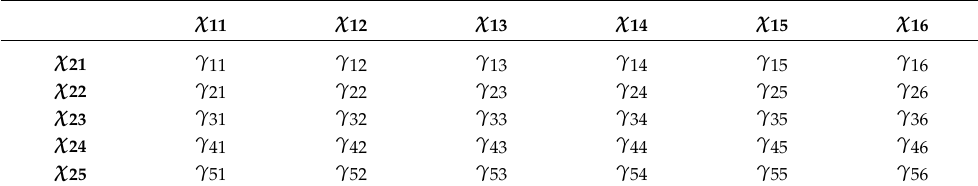
Table 4. Definition of stress distribution curve at weld 1 in each model.